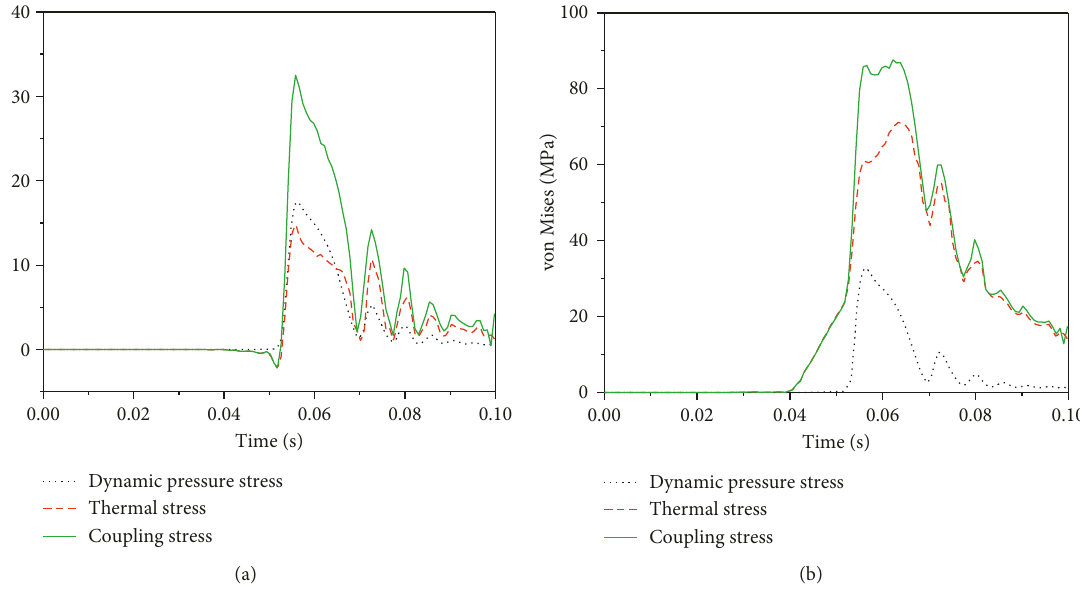
Figure 13: (a) Circumferential stress and (b) von Mises stress of characteristic point